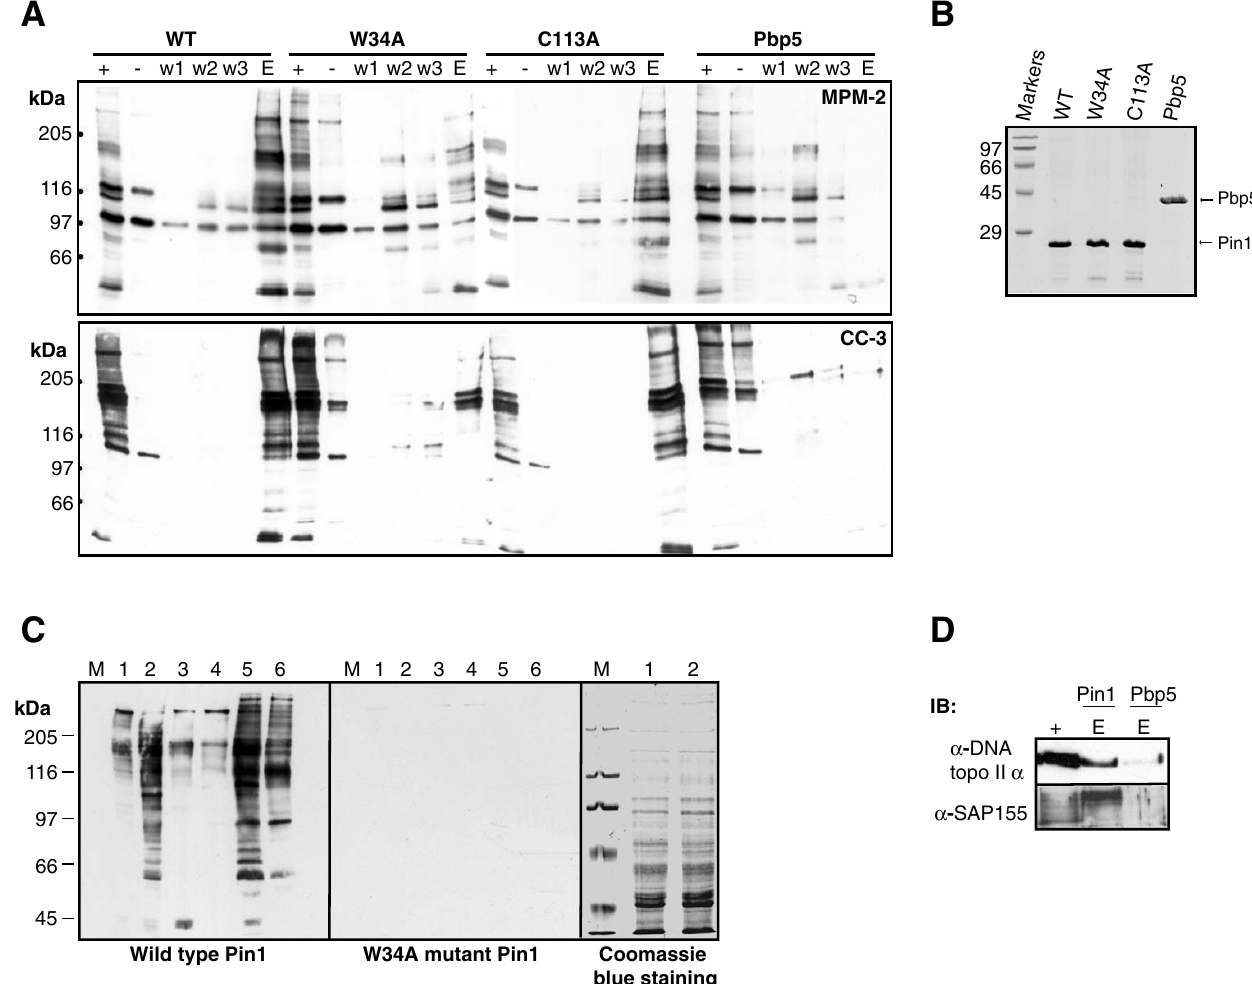
Figure 4 The direct interaction of Pin1 with CC-3 and MPM-2 mitotic antigens involves its WW domain. (A) Mitotic HeLa cell homogenates were incubated with histidine-binding resins saturated with different his-tagged proteins. WT: wild type Pin1; W34A: a Pin1 protein mutated in the WW domain; C113A: a Pin1 protein mutated in the PPIase domain; Pbp5: an irrelevant protein used as a control. Aliquots from the initial lysate (+), the flowthrough (-), the washes (w1 to w3) and the eluted frac- tions (E) were subjected to SDS-PAGE and immunoblotting. The Pin1 WT and C113A resins retained more MPM-2 and CC-3 mitotic antigens than the WW mutant W34A and the Pbp5 control resins. (B) Coomassie blue staining of a 15% acrylamide gel of the fractions eluted from the different resins in (A) showing that the initial amounts of the bound his-tagged proteins were similar. (C) Blot overlay experiments using either the wild type or the WW mutant Pin1 protein as a probe showing the direct interaction of wild type Pin1 with CC-3 interphase (lane 3) and mitotic (lane 5) antigens as well as with MPM-2 interphase (lane 4) and mitotic (lane 6) antigens, obtained by immunoprecipitation. Lanes 1 and 2 correspond to total homogenates prepared from asynchronous and mitotic HeLa cells respectively. Pin1 did not bind to the Mr markers (lane M) nor to the major bands of the total homogenates (lanes 1 and 2) visualized by Coomassie blue staining (right panel) but did bind strongly to the CC-3 and MPM-2 antigens. No binding was observed when the W34A mutant protein was used as a probe (middle panel). (D) Pin1 specifically binds to SAP155 and DNA topoisomerase II α . Same experiment as that described in (A) except that the eluted fractions from the his-tagged Pin1 and Pbp5 resins were immunoblotted with antibodies to DNA topoisomerase II α and